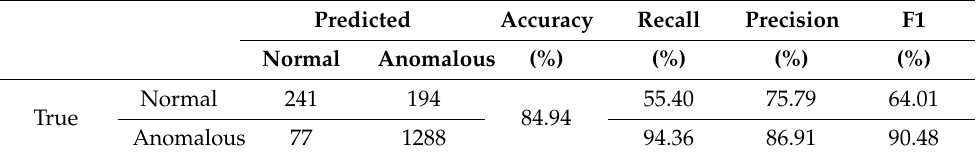
Figure 5. ( a ) Training and validation loss and ( b ) training and validation accuracy for the second experimentation. Table 7. Confusion matrix and related performance metrics for the test set in the second experimen-